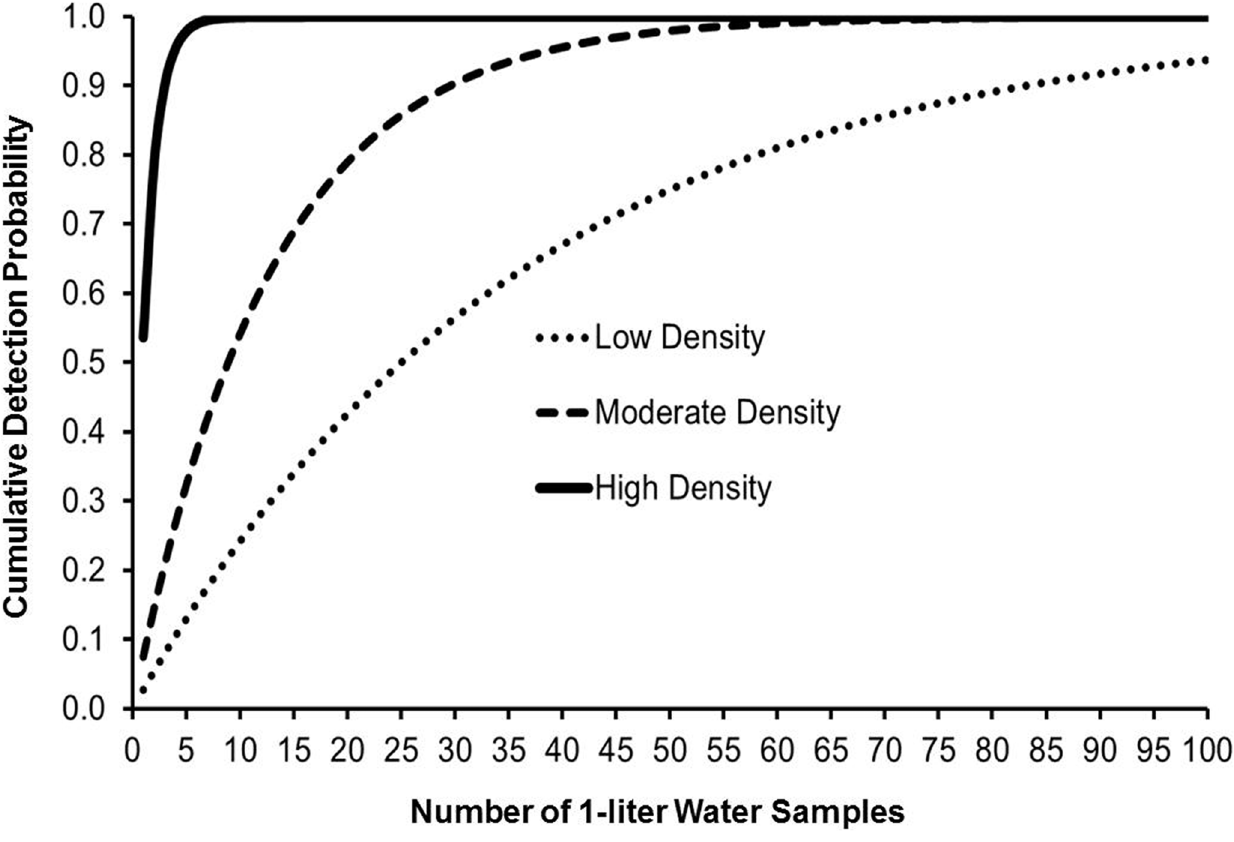
Figure 1. Predicted cumulative African jewelfish eDNA detection probability with an increasing number of 1-L water samples. Detection estimates are based on parameter estimates from the best-approximating hierarchical logistic regression models relating African jewelfish eDNA detection/non-detection data to pond- and sample-level covariates and were calculated for low density (0.32 fish/m 3 ), moderate density (1.75 fish/m 3 ), and high density (5.24 fish/m 3 ) populations assuming a water temperature of 28 C.